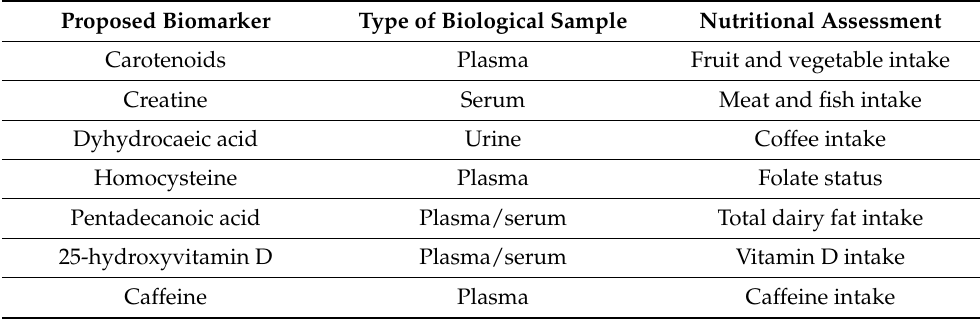
Table 1. Some examples of nutritional biomarkers. Proposed Biomarker Type of Biological Sample Nutritional Assessment Carotenoids Plasma Fruit and vegetable intake